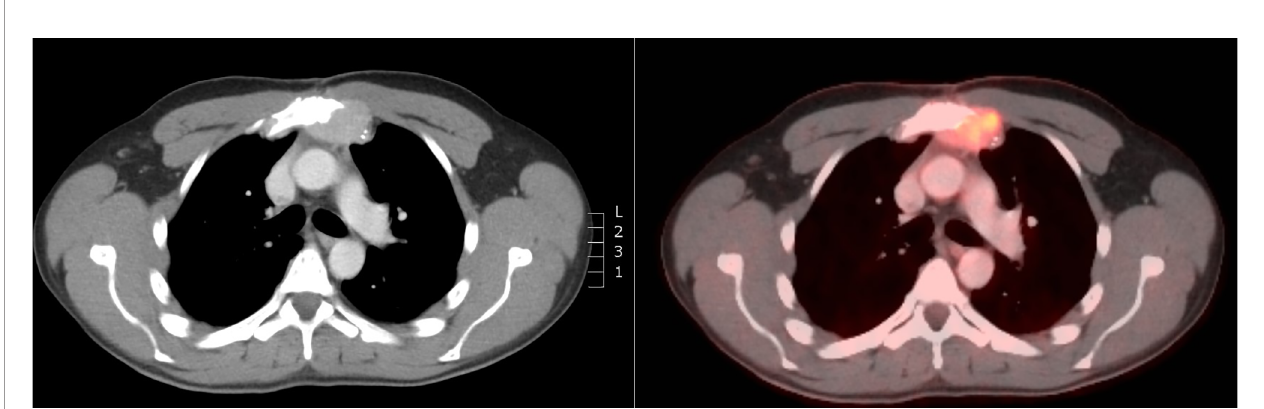
FIGURE 2 | FDG PET/CT at diagnosis of inoperable retrosternal relapse with bone invasion.